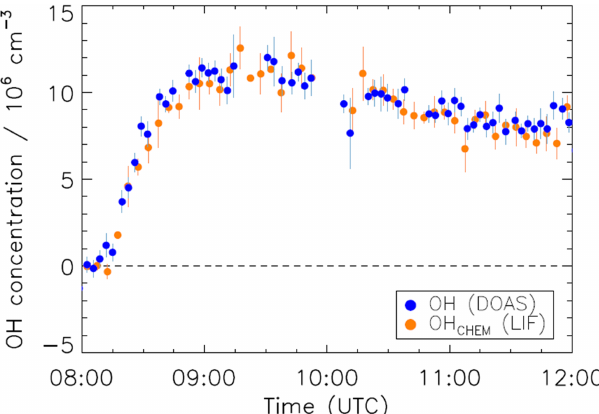
Figure 4. Time series of OH concentrations measured by DOAS and LIF (with CMR) in humidified synthetic air in the SAPHIR chamber. The measured OH reactivity in the chamber air was less than 2s − 1 . The chamber was illuminated by solar radiation, and OH was mainly produced by solar photolysis of traces of nitrous acid emitted from the chamber walls. The data shown are averaged over